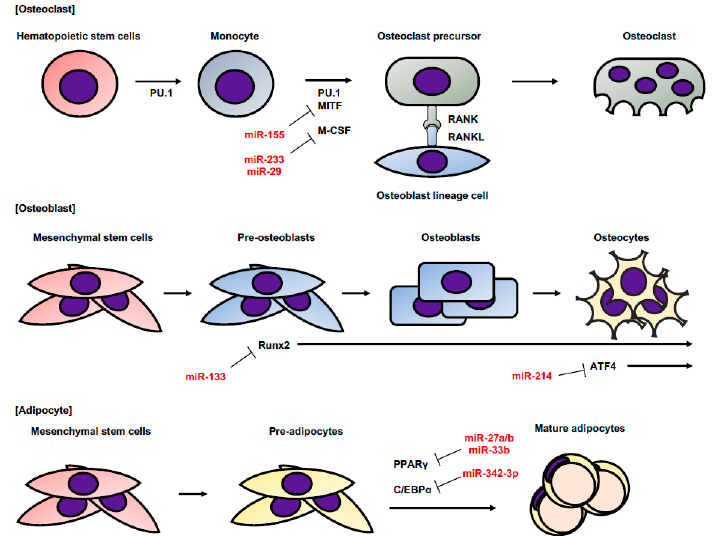
Figure 2. The differentiations of osteoclasts, osteoblasts, and adipocytes. This figure shows the order of normal differentiation of osteoclasts, osteoclasts, and adipocytes. The genes related to their differentiation at each stage and the regulatory miRNAs are also shown. This figure is drawn with reference to References [12] and [18].